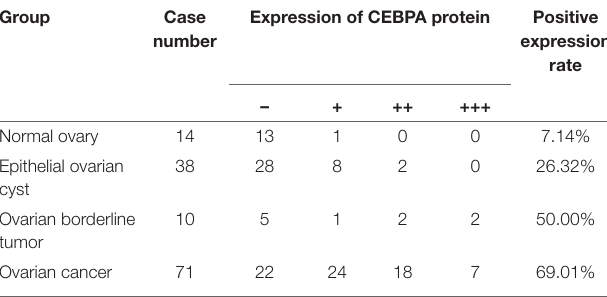
TABLE 2 | Positive expression rate of CEBPA in different ovarian